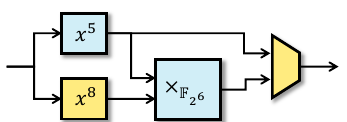
Figure 2: Efficient implementation of the 6-bit quadratic power map x 5 (class 2263) together with its inverse.